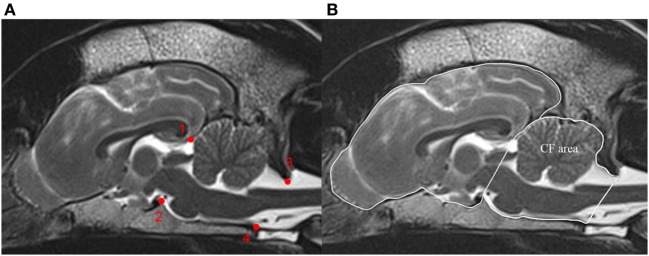
Calculation of the caudal fossa ratio (CFR) on midsagittal brain images. The figure shows midsagittal T2-weighted magnetic resonance images of the brain of a control dog. (A) Bony structures used to identify the boundary of the caudal fossa. (1) Most rostral aspect of the tentorium cerebellum, (2) dorsum sella turcica, (3) caudodorsal margin of the foramen magnum, and (4) ventral margin of the foramen magnum. (B) Measurements on midsagittal T2-weighted MRI figure displays outline of the caudal fossa (CF area) and total cranial cavity (peripheral boundary line) for area measurements. CFR is calculated as CF area/total cranial cavity area.